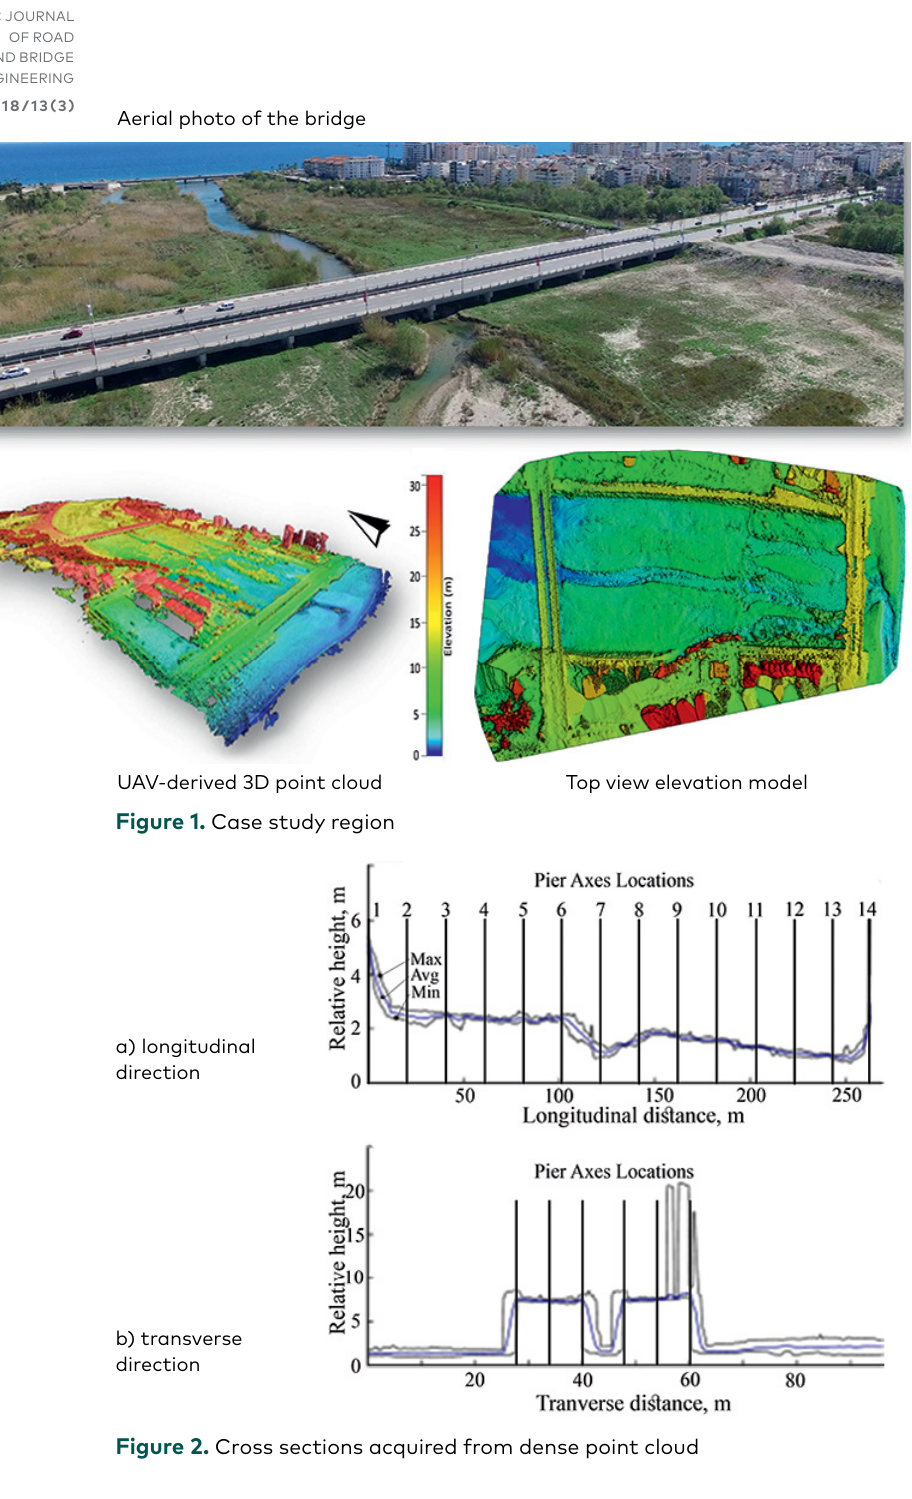
Figure 2. Cross sections acquired from dense point cloud